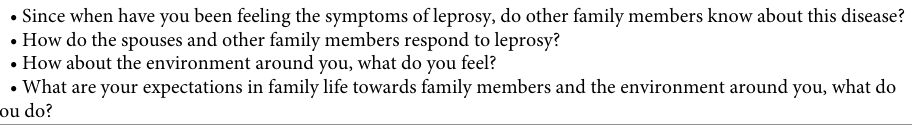
Table 2. Example of Relevant Questions.